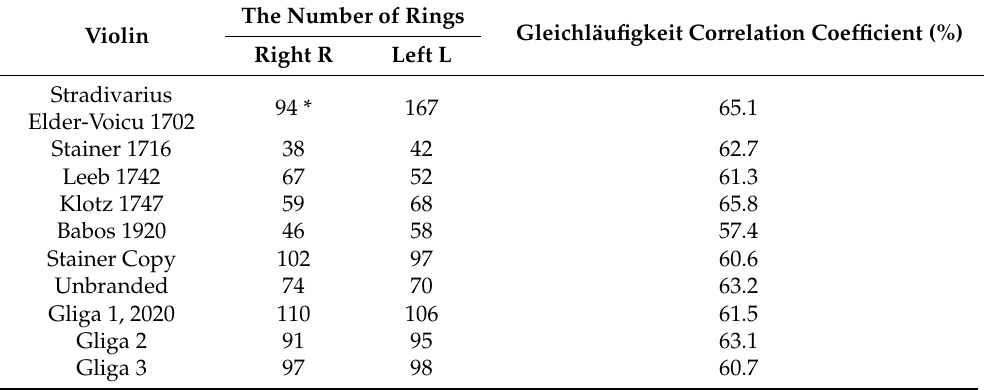
Table 2. Indicators for characterizing the symmetry of the top halves in relation to the annual rings (* inaccessible for the measurement all annual rings in that